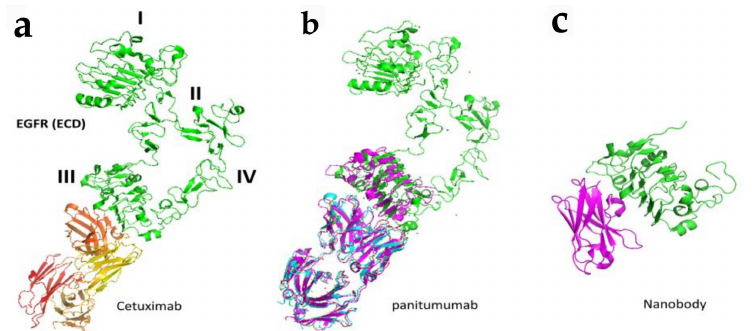
Figure 5. Binding modes of antibodies and nanobodies to EGFR extracellular domain. ( a ) Fab region of antibody cetuximab (red and yellow) bound to EGFR (green) domain III of ECD (PDB ID: 1YY9). ( b ) Panitumumab bound to EGFR ECD at domain III (PDB ID: 5SX4). ( c ) Crystal